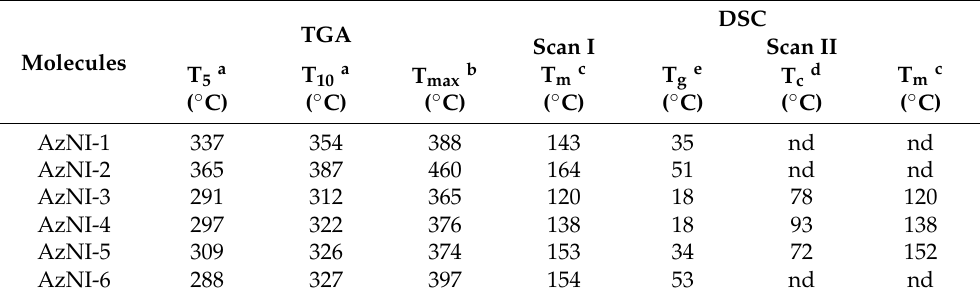
Table 1. Thermal properties—thermal stability and temperatures of phase transitions (with glass transition temperature) of the investigated molecules.